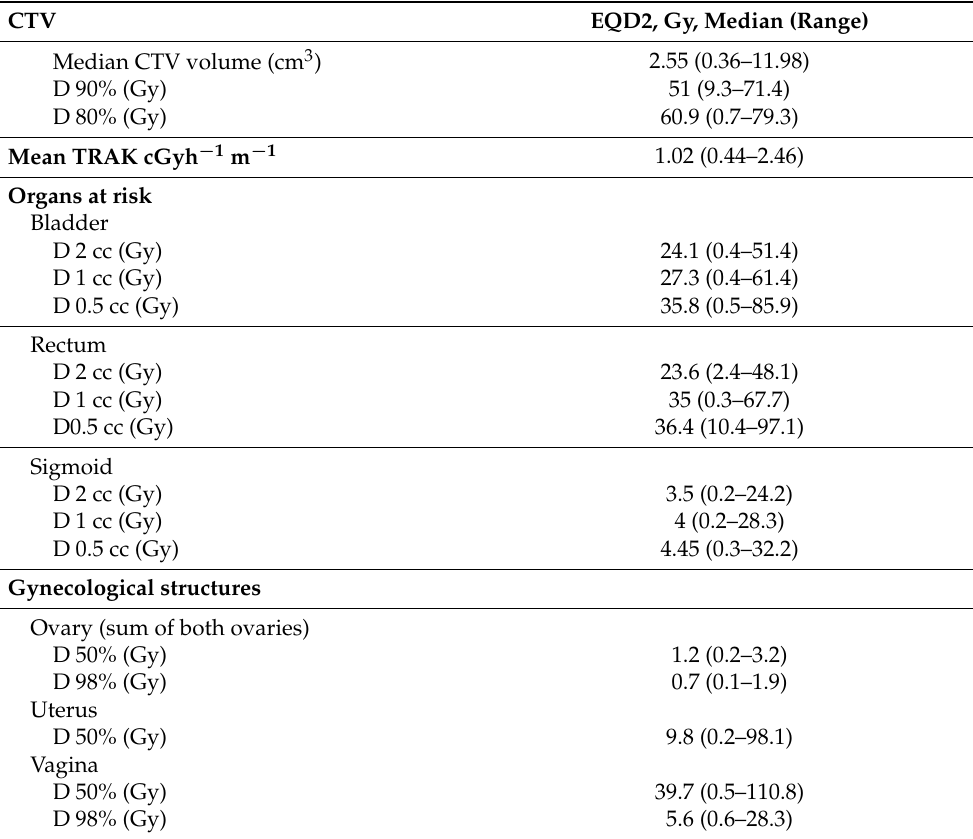
Table 2. Pulse-dose-rate brachytherapy: dosimetric